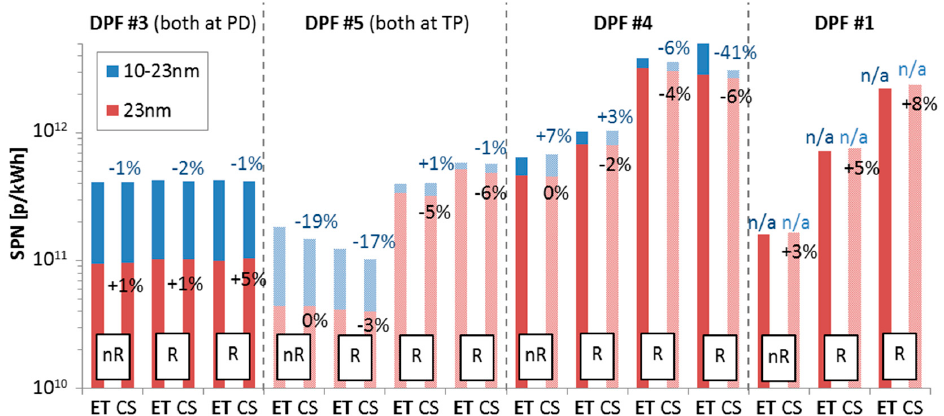
Figure 4. Solid particle number (SPN) emissions during one non-regenerating (symbol nR) and 2 or 3 regenerating (symbol R) hot start WHTCs measured with the “Golden” system with catalytic stripper (CS) and the PMP system with evaporation tube (ET, bold) connected both at the proportional partial flow system (PD, dark colours) for DPF #3, both at the tailpipe (TP, light colours) for DPF #5, one at the tailpipe and the other at the PD for DPF #4 and DPF #1. Numbers give the difference of the CS system compared to the ET system for 23 nm and 10 nm measurements.